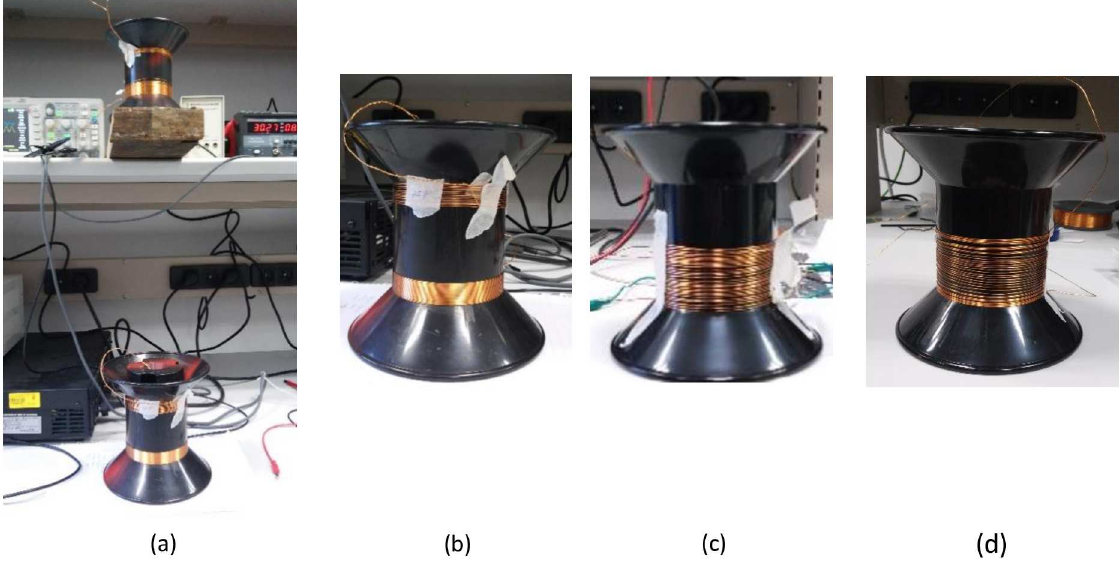
Fig 15. (a) An experimental setup, showing the magnetictransmitter and receiver coils. Here, the transmitter is 30 turn coil with minimalpitch. The receiveris 30 turn coil located50 cm above the transmitter. (b) Transmitting coils for case (aa) 30 turn minimal pitch coil, and for case (bb) 15 turn increasedpitch coil. (c) Transmitting coil for case (cc) 30 turn increasedpitch coil. (d) Optimal current distributionsingle layer